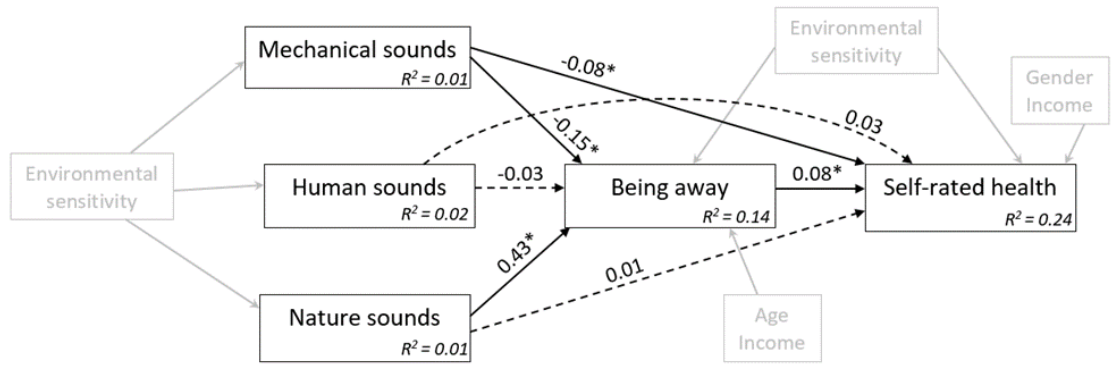
Figure 2. Structural equation model showing the estimated paths linking perceived sounds to feelings of “being away” and self-rated health. Note: Unstandardized regression weights with their significance level are given for each path. R 2 shows proportion of variance explained in endogenous variables. Coefficients marked with an asterisk (*) are statistically significant at p < 0.05. Control variables are shown in grey. Covariances, associations between control variables, and errors terms are not displayed to enhance readability.